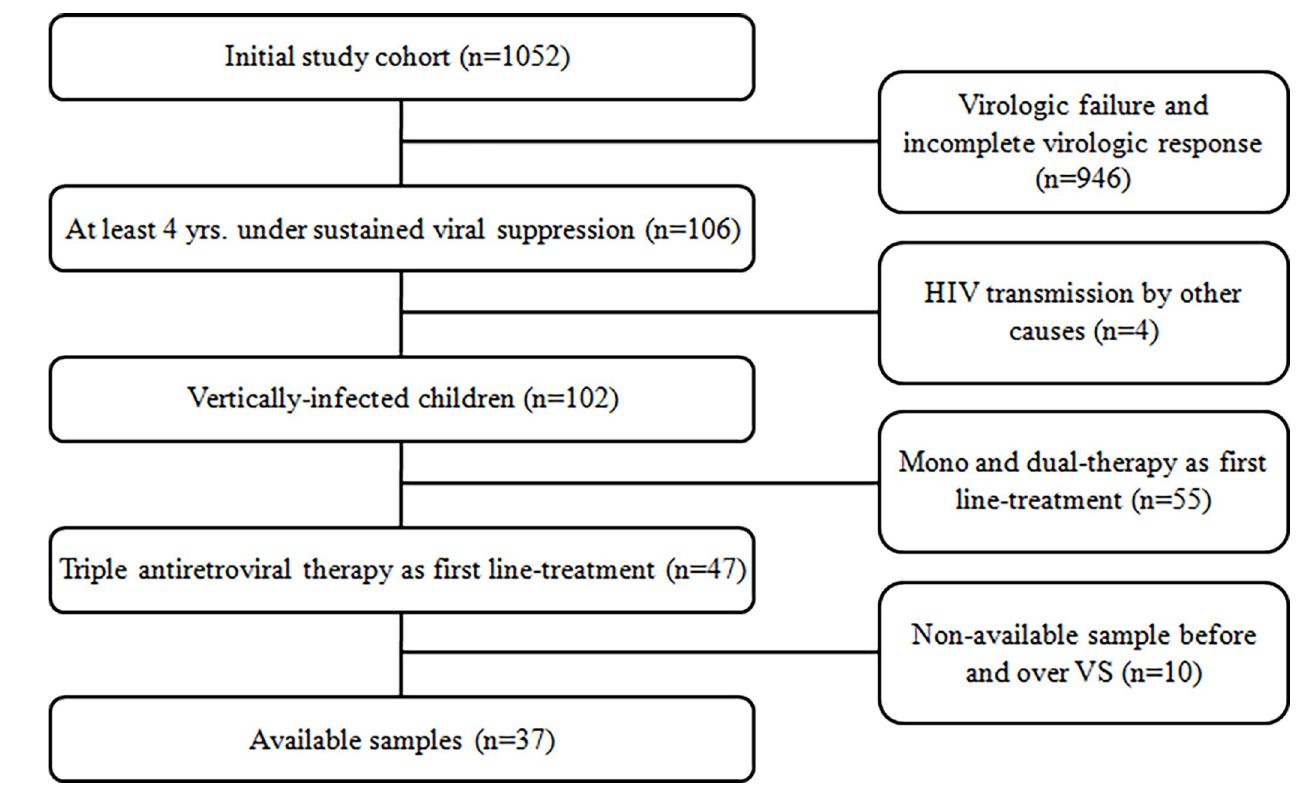
Fig 1. Study population. Newly HIV-1 infected children detected in Garrahan Pediatric Hospital from 1900 to 2008.